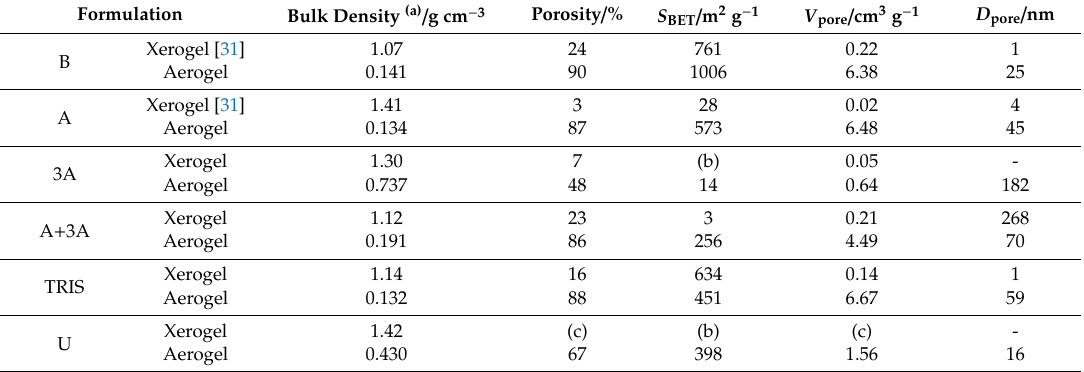
Table 2. Structural properties of the prepared functional aerogel and xerogel adsorbents.